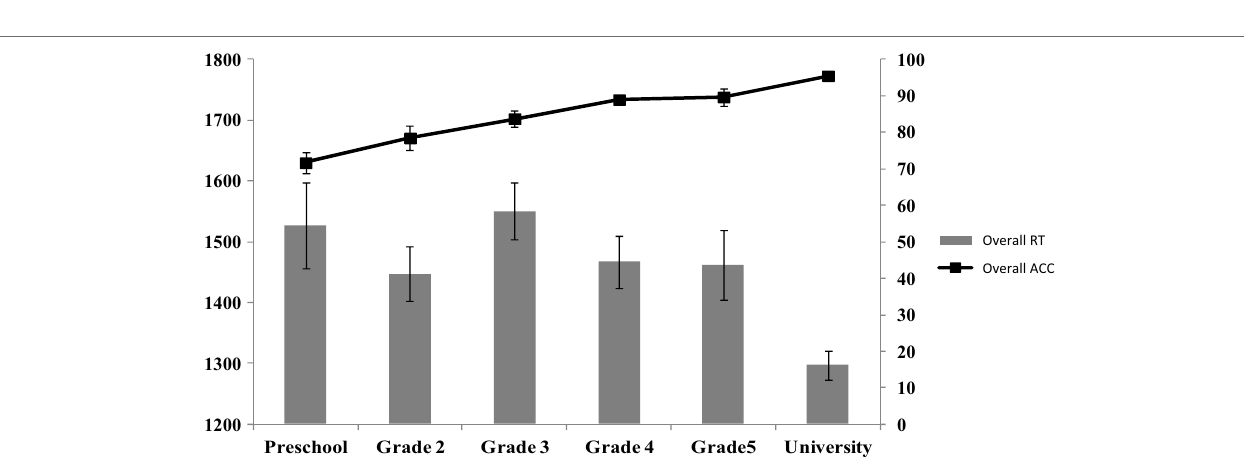
FIGURE 1 | Means and 95% confidence intervals of the orthographic transparency effect (RT on opaque stimuli minus RT on transparent stimuli) obtained of each age group. The dots represent the individual data.